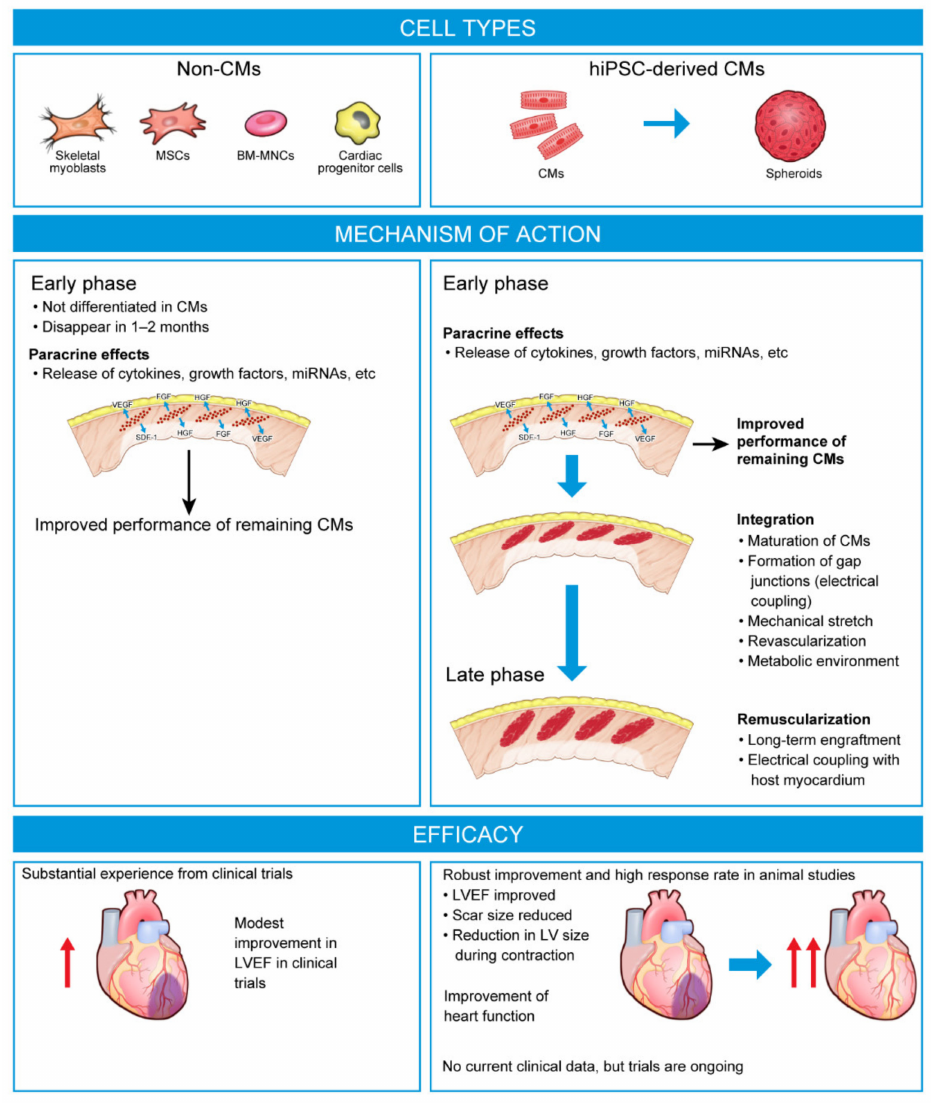
Figure 1. Mechanism of action of next-generation cell therapies versus first-generation cell thera- pies. In contrast to first-generation therapies, which are largely limited to paracrine effects, next- generation therapies aim to promote remuscularization of the heart. BM-MNC, bone marrow-derived mononuclear cell; CM, cardiomyocyte; FGF, fibroblast growth factor; HGF, hepatocyte growth factor; hiPSC-CM, human-induced pluripotent stem cell-derived cardiomyocyte; LV, left ventricle; LVEF, left ventricular ejection fraction; miRNA, micro ribonucleic acid; MSC, mesenchymal stem cell; SDF-1, stromal cell-derived factor-1; VEGF, vascular endothelial growth